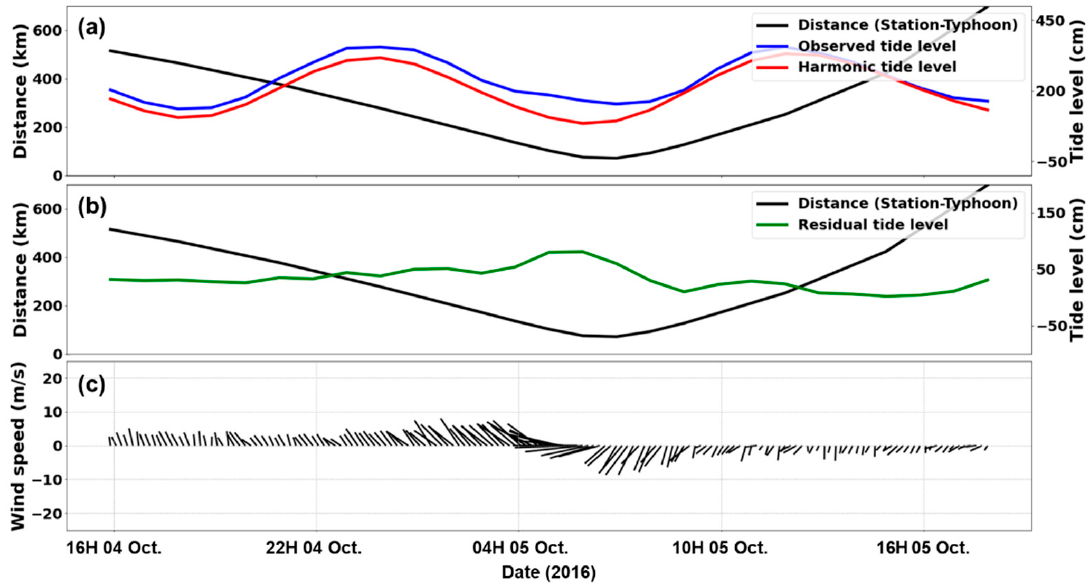
Figure 9. Time-series of observational data from Wando tidal station during Typhoon Chaba. ( a ) Astronomical tide, ( b ) residual tide level, and ( c ) wind components, where direction and length represent wind direction and speed, respectively.